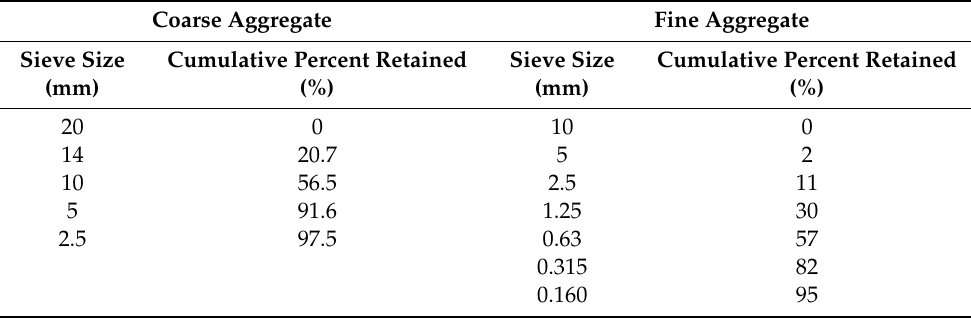
Table 5. Particle size distributions of aggregate